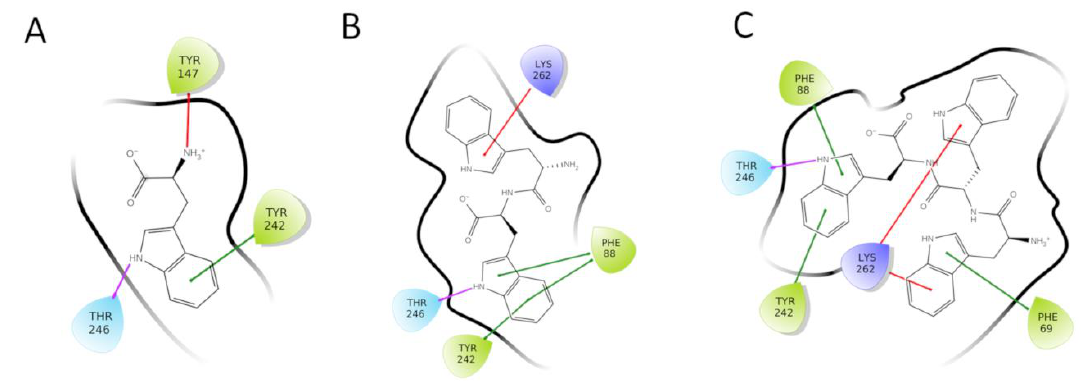
Figure 2. 2D representations of the interactions established by tryptophan ( A ), di-tryptophan ( B ), and tri-tryptophan ( C ) within the TAS2R4 orthosteric binding site. H-bonds, π – π interactions, and π –cation interactions are represented as magenta, green, and red lines, respectively.